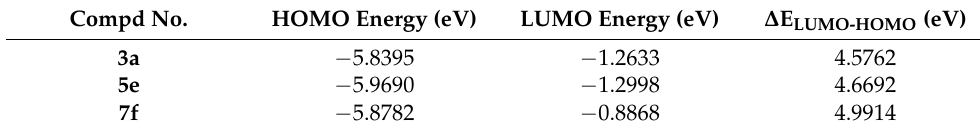
Figure 5. Frontier molecular orbitals of compounds 3a ( A ), 5e ( B ) and 7f ( C ). Table 3. Molecular frontier orbital parameters of compounds 3a , 5e and 7f